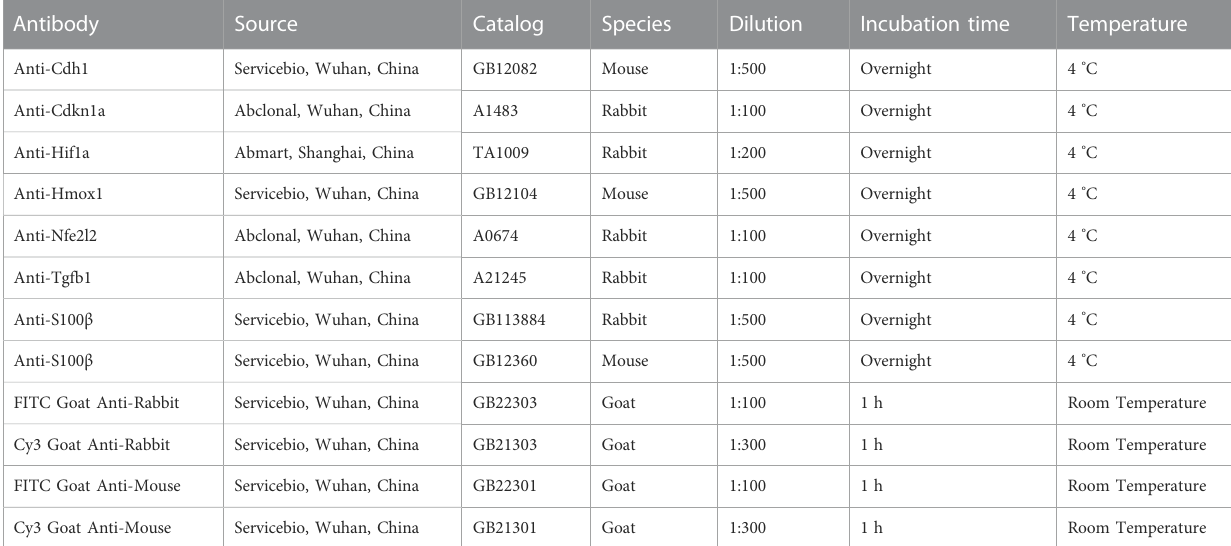
TABLE 1 List of antibodies used in this study.